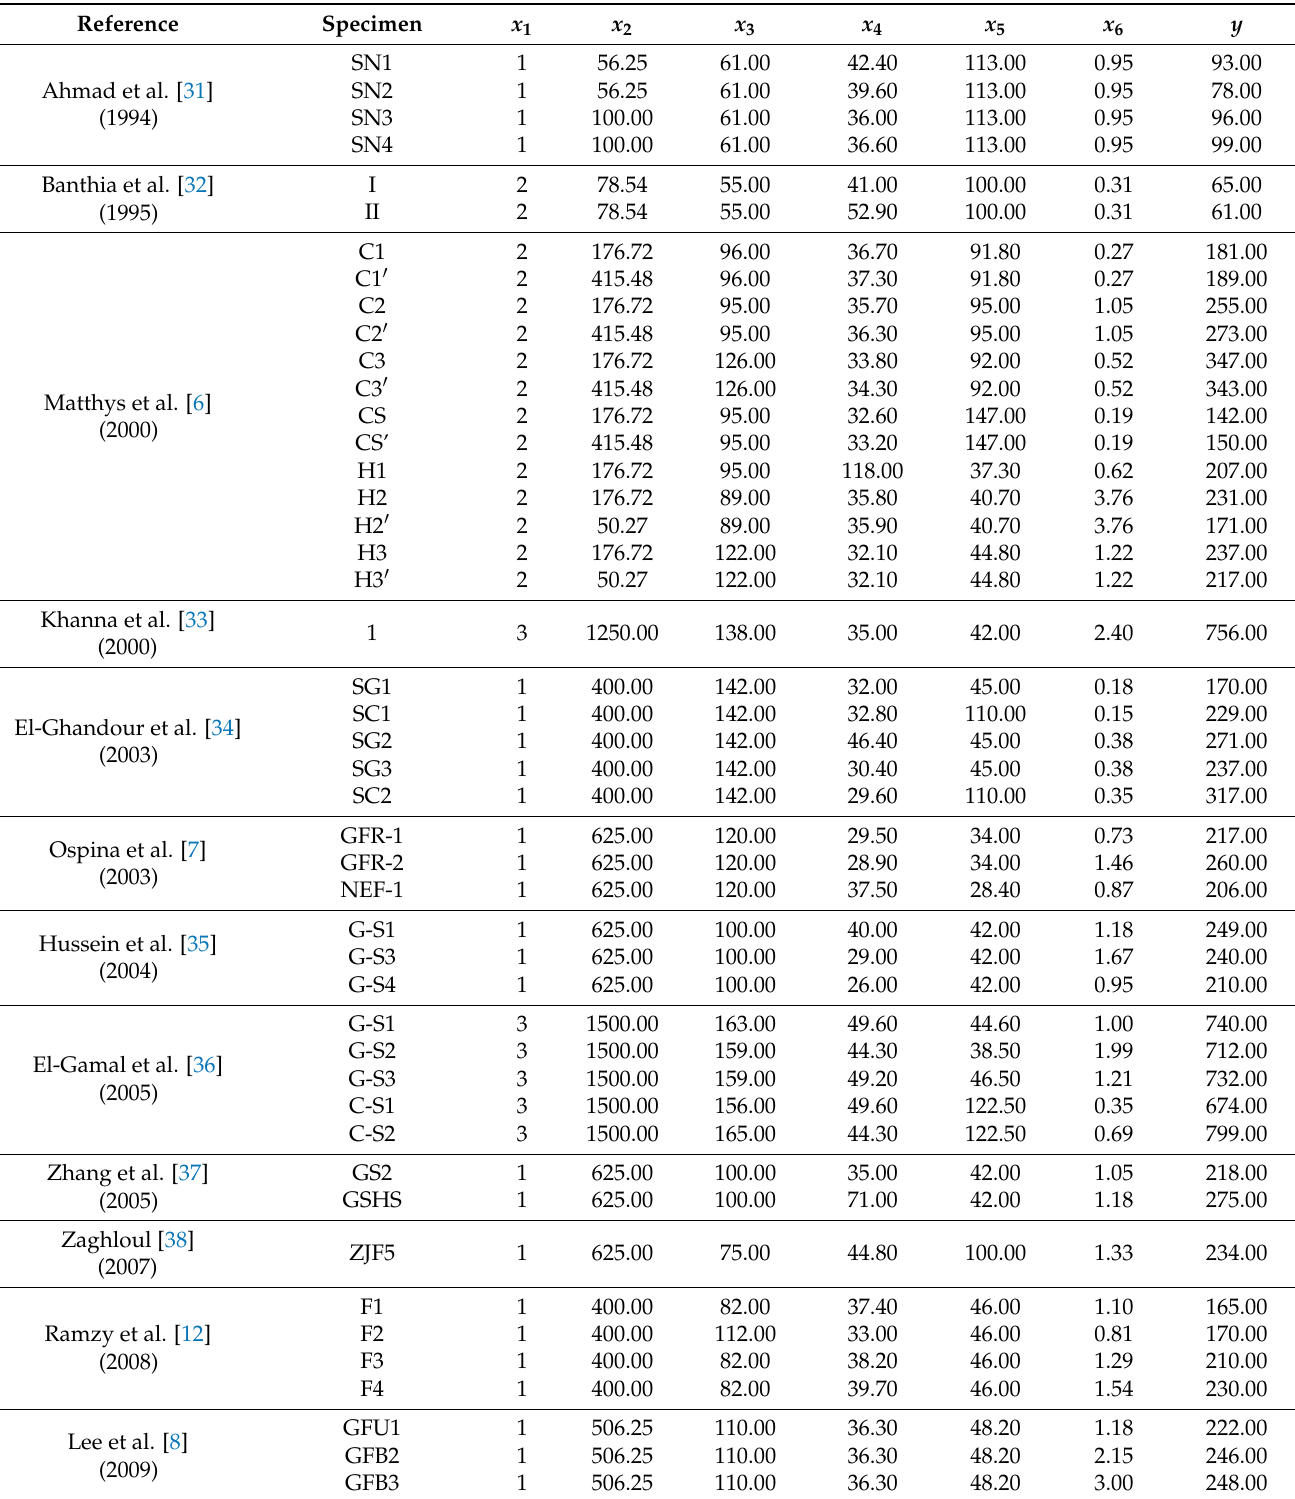
Table A1. Database of punching shear strength for FRP reinforced concrete